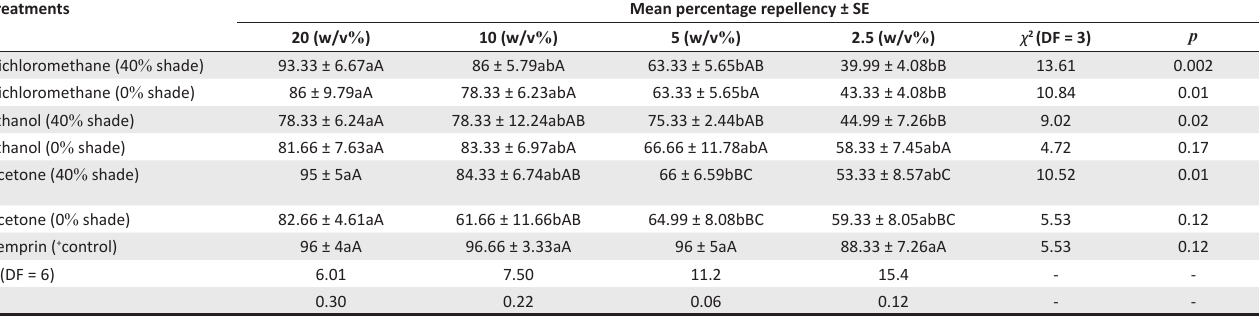
TABLE 4: Repellent effects (mean percentage repellency) of extracts of Allium porrum from aerial parts against grapevine mealybug ( Planococcus ficus ). Treatments Dichloromethane (40 %